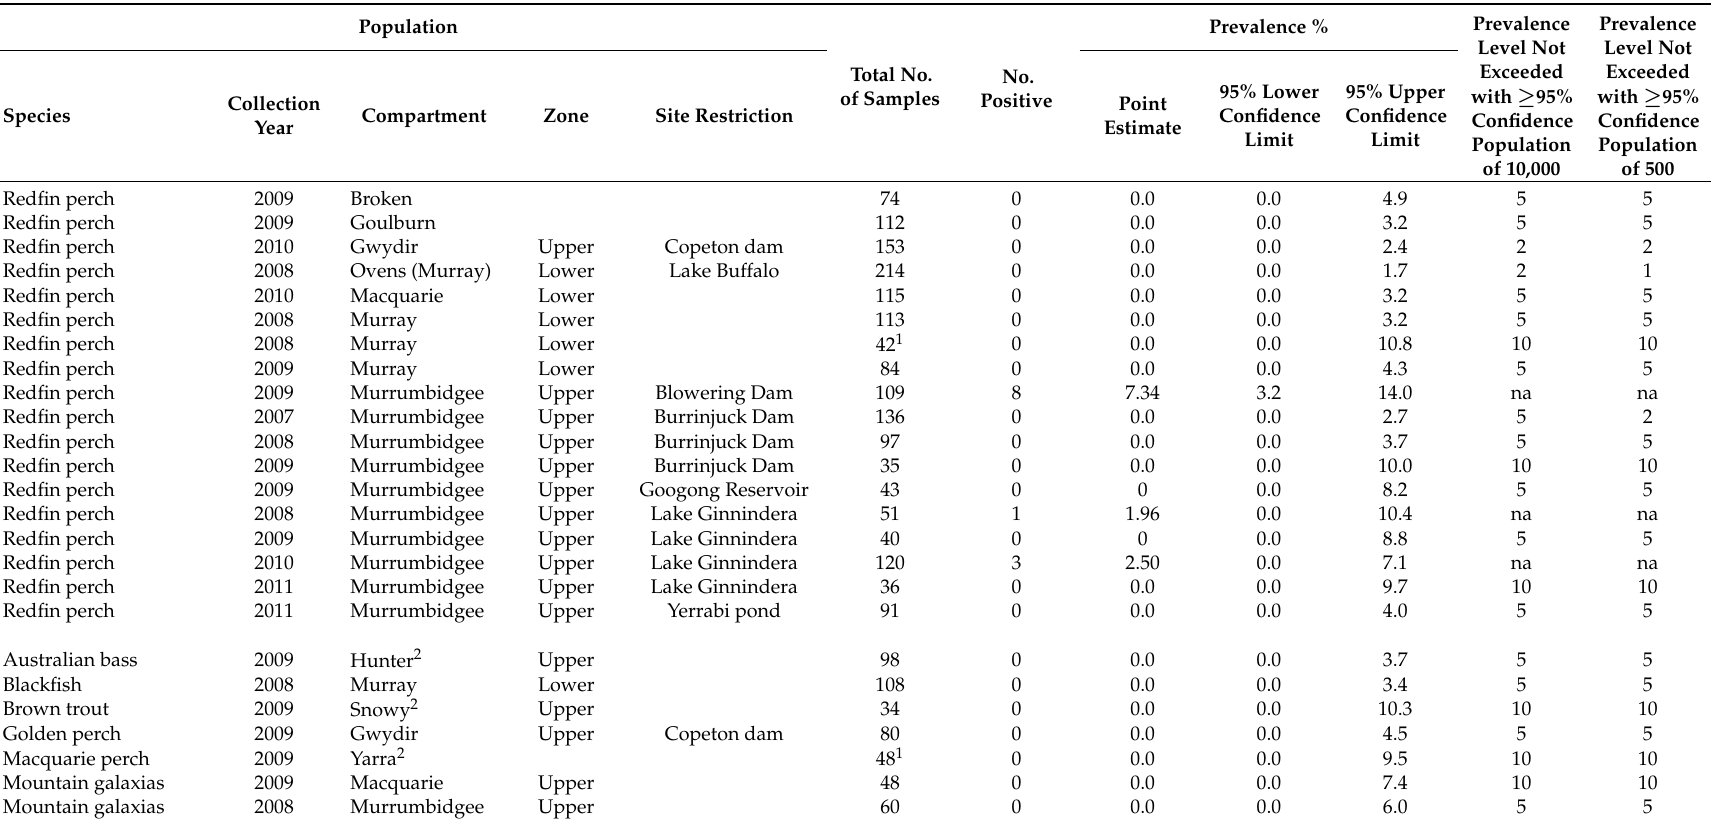
Table 1. Estimated true prevalence of Epizootic haematopoietic necrosis virus (EHNV) in redfin perch and other species based on testing tissue and serum samples collected between July 2007 and June 2011. Where sample size was >30 per population, and prevalence, which results indicate, was not exceeded for population sizes of 10,000 and 500. A population was defined as a group of fish restricted by species, year of collection, catchment, zone, and